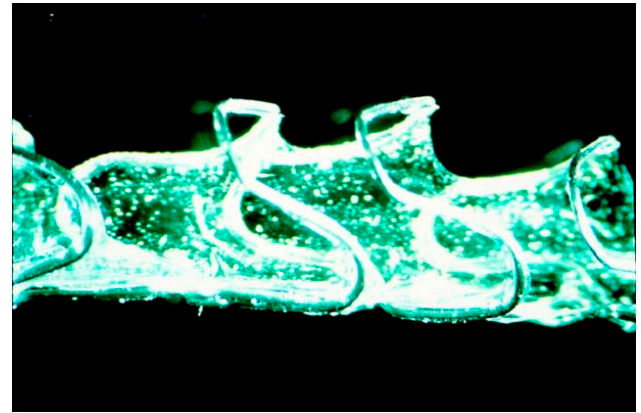
Figure 3. Polymer test strip cast asymmetrically on the coil stent vehicle [33]. The polymer was processed to strips 75 to 125 µ m in thickness of specimen.The strips were cast longitudinally onto a balloon-expandable stent and covered ≈ 90° of the stent circumference. Copyright permisson from Wolters Kluwer Health Inc.